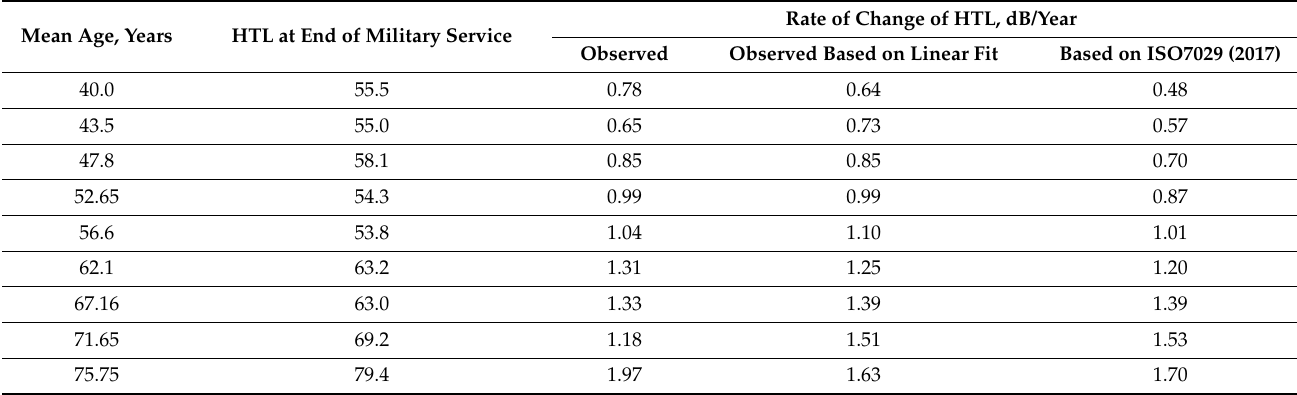
Table 5. As Table 2, but for the right ear at 4